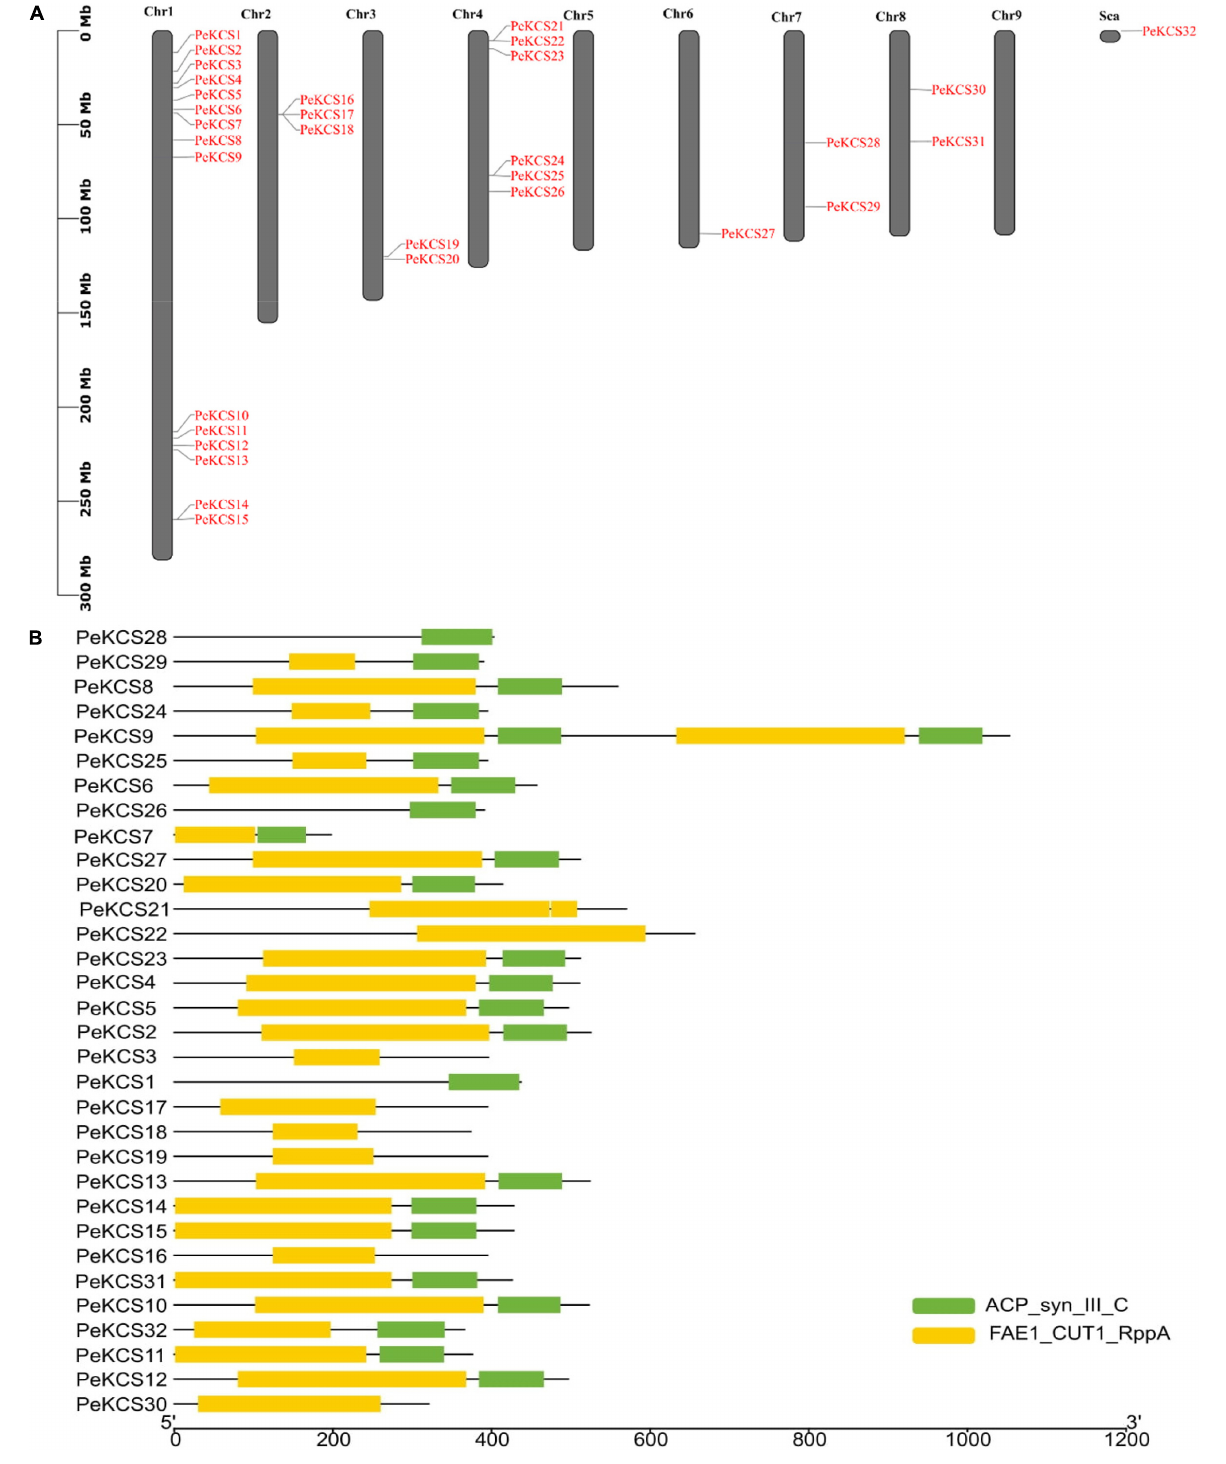
Frontiers in Plant Science |